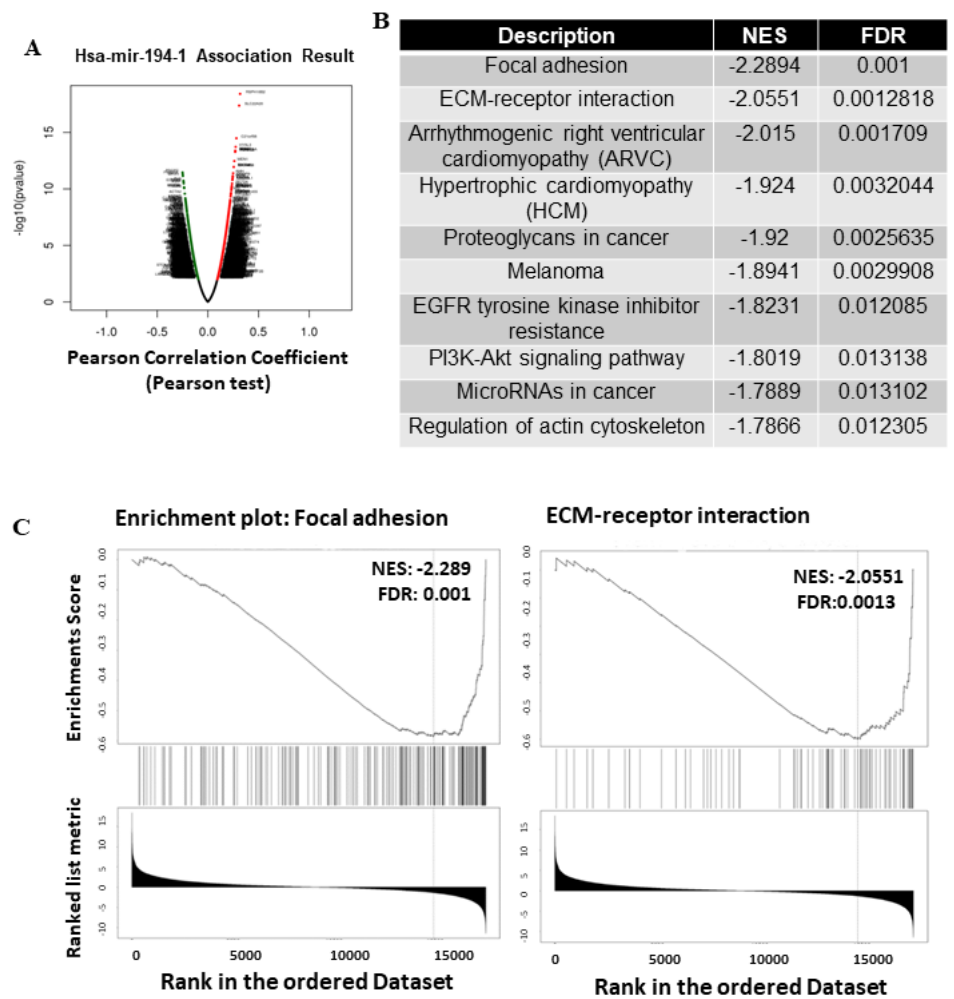
Figure 3. miR-194-5p is associated with disease aggressiveness in breast cancer. Key genes targeted by miR-194-5p were analyzed GSEA and GO enrichment assay in breast cancer: ( A ) The X-axis represents the log 2 (fold change), and the volcano plot shows the log 2 (fold change) vs. − log 10 ( p -value); ( B ) negatively-regulated genes by miR-194-5p were categorized. Top 10 pathways selected from KEGG; ( C ) top two enrichment plots from the GSEA results, including focal adhesion and ECM-receptor interaction. GSEA revealed negative enrichment of miR-194-5p-altered genes in focal adhesion and ECM–receptor interactions.